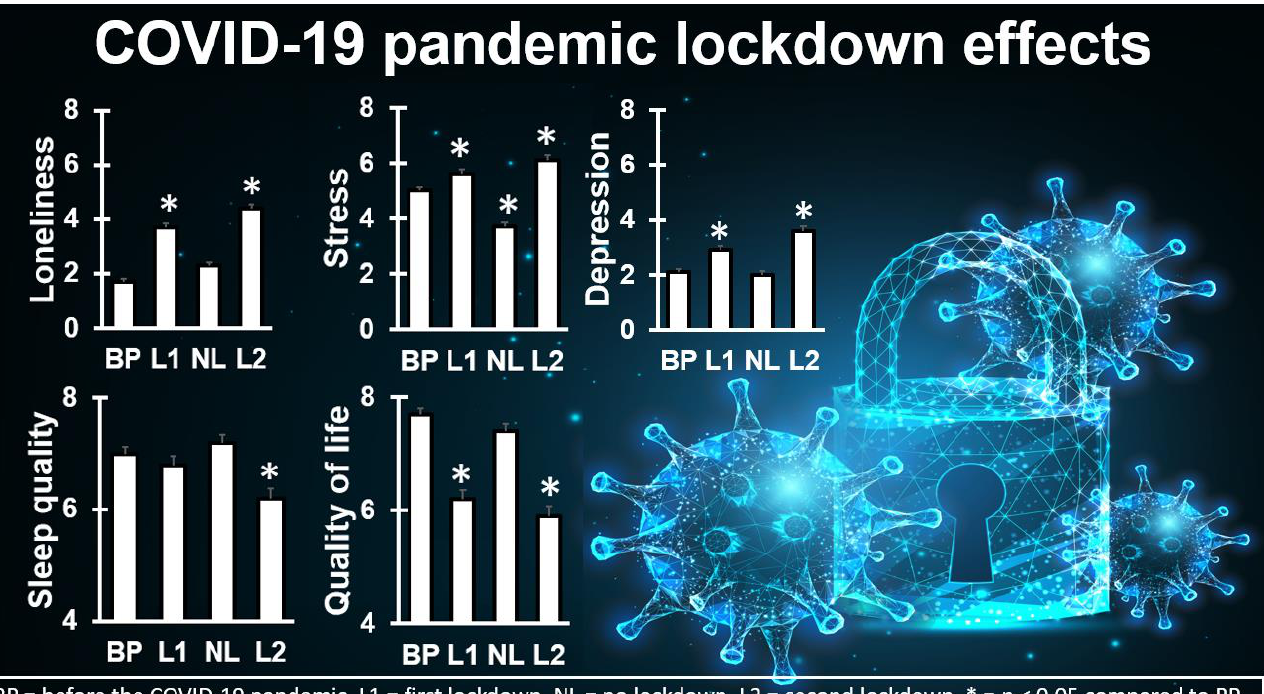
Figure 1. Examples of COVID-19 lockdown effects among Dutch university students. Loneliness, stress, and depression were assessed on a scale ranging from 0 (absent) to 10 (extreme) [12]. Sleep quality and quality of life were assessed on a scale ranging from 0 (very poor) to 10 (excellent) [12]. Significant ( p < 0.0167) negative effects of lockdown were found for all measures. Data from refer- ences [10,11]. Permission to use the background image was obtained from Depositphotos.